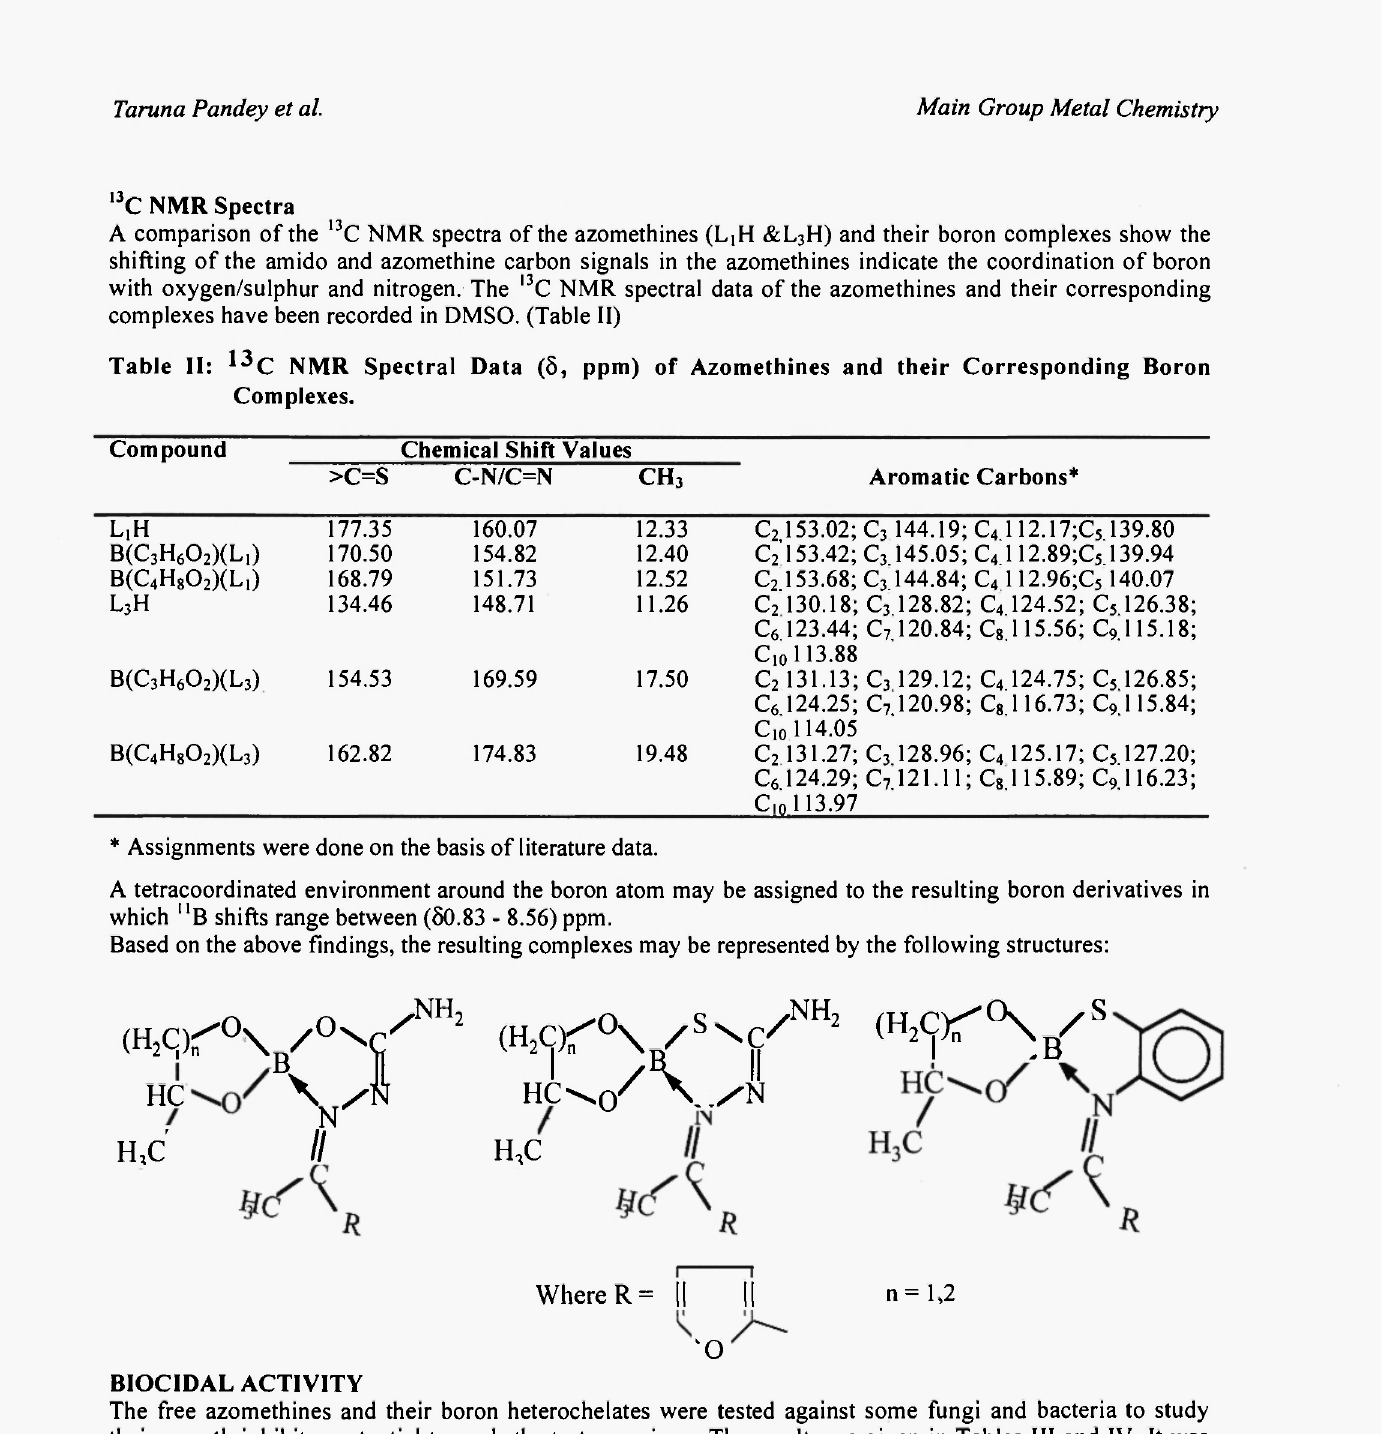
Table II: ^C NMR Spectral Data (5, ppm) of Azomethines and their Corresponding Boron